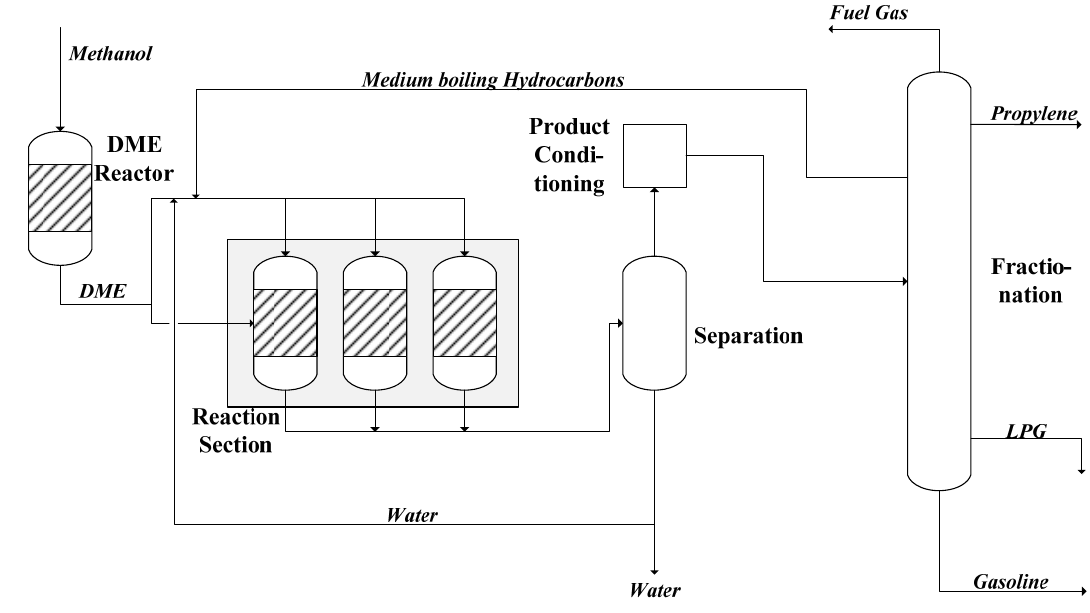
Figure 3. Process flow diagram methanol-to-propylene process